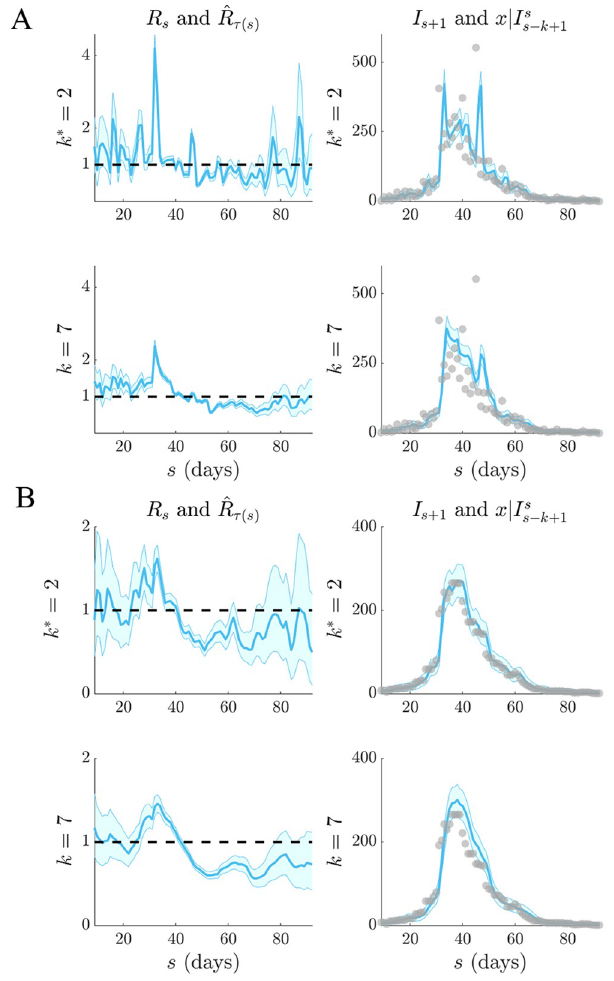
Fig 9. Selection for pandemic influenza (1918). Left graphs compare ^ R intervals) at optimal APE window length k � to weekly sliding windows ( k = 7), which were recommended in [10]. Right graphs give corresponding one-step-ahead predictions x j I s lines are the R = 1 threshold (left) and dots are the true incidence I s (right). Panel (A) directly uses the empirical influenza (1918) data [10] while (B) smooths outliers in the data as in [16].